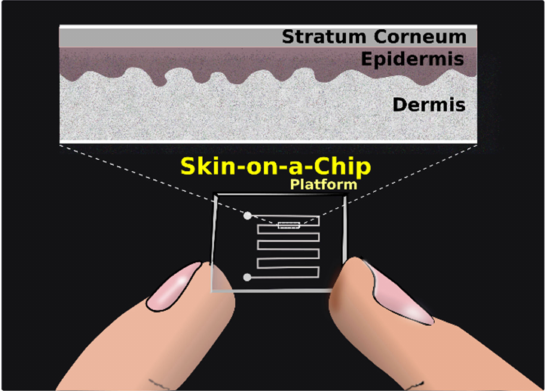
Figure 5. Sketch of a microfluidic skin-on-a-chip platform.